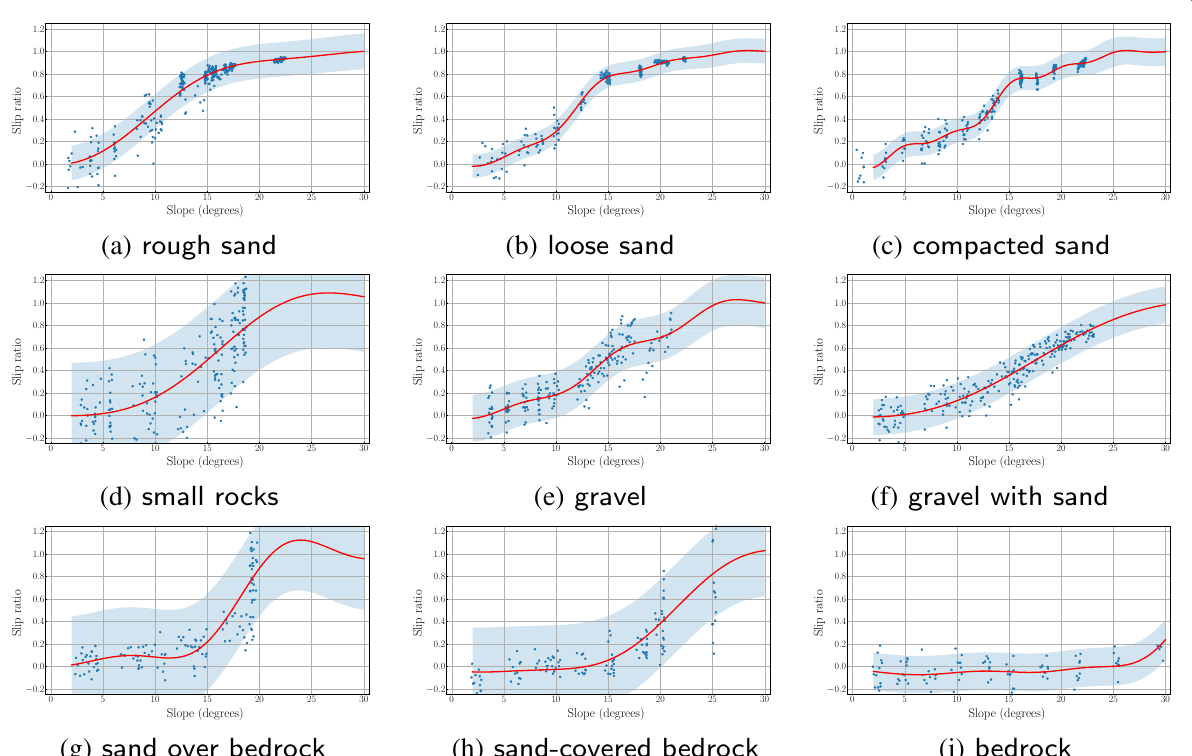
Fig. 6 Reference GP regression model for the slip vs. slope characteristics of each surface class. Each model was learned from 75% of all the data in the corresponding surface domain. The red curve represents the predictive mean while the blue-shaded area represents the confidence interval with 2-standard deviation around the